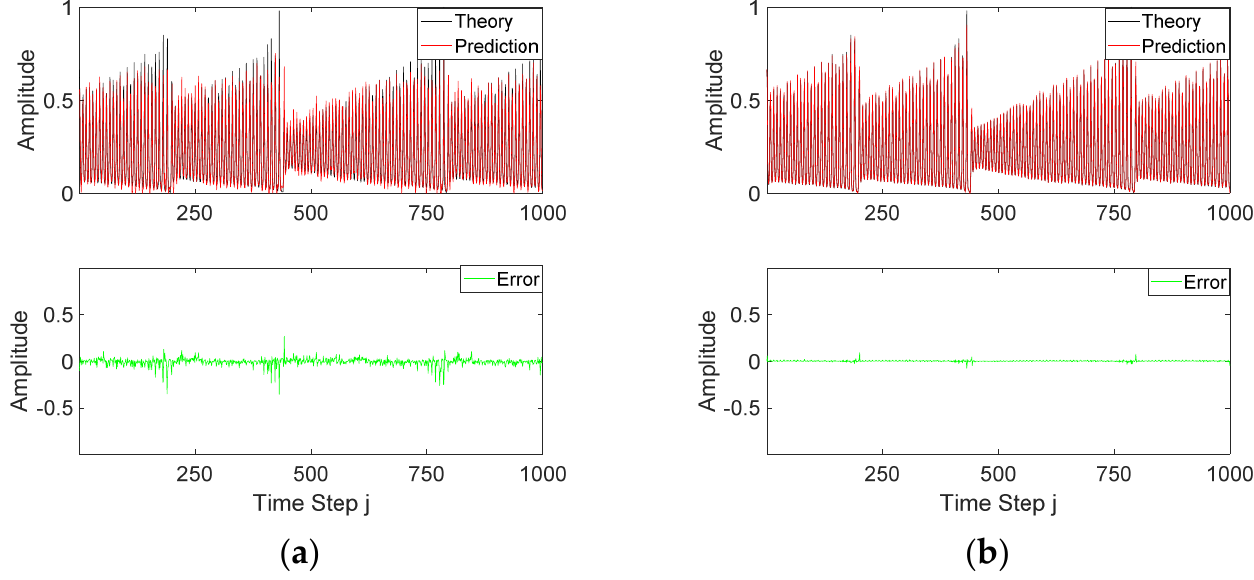
Figure 3. Temporal theory (black) and prediction (red) waveforms, and prediction error (green) from ( a ) conventional RC and ( b ) proposed RC. The interval of θ = 3 ps corresponds to a processing speed of about T − 1 = 3.3 GSample/s .